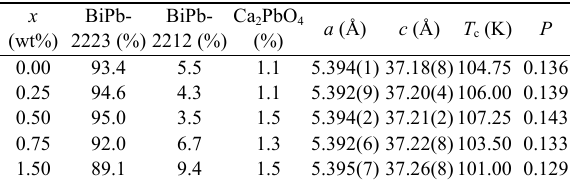
Variation of relative volume fraction of BiPb-2223, BiPb-2212, and Ca 2 PbO 4 phases, lattice parameters, T c , and P for (BaSnO 3 ) x /BiPb-2223